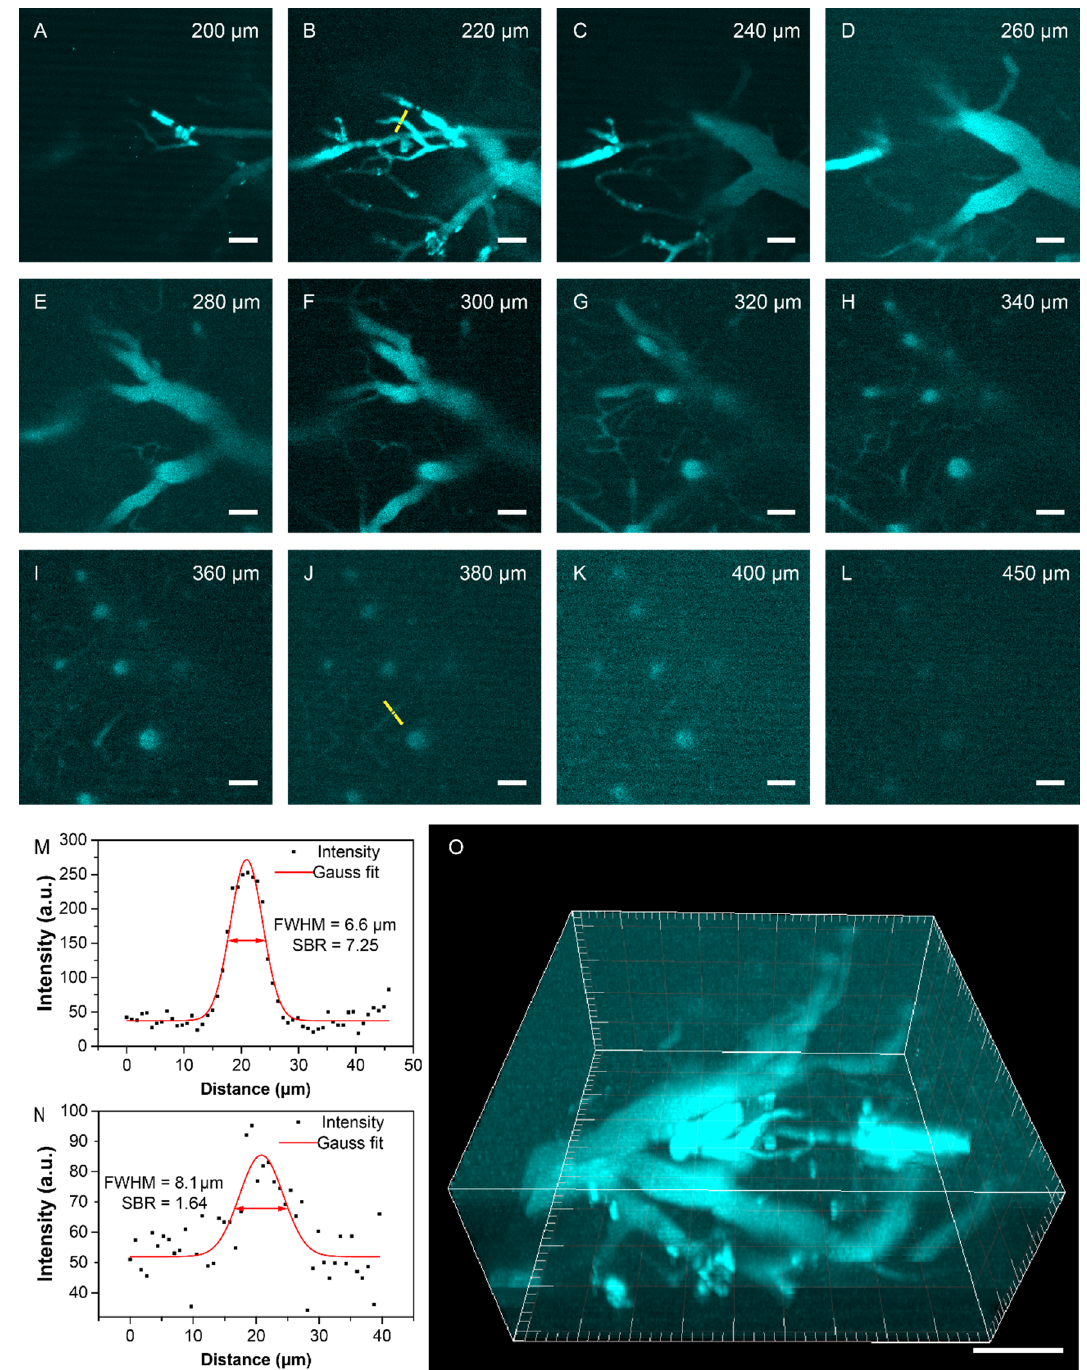
Figure 4. In vivo anti-Stokes fluorescence confocal microscopic imaging. ( A–L ) In vivo anti-Stokes fluorescence confocal microscopic images of brain blood vessels at various depths following the injection of BPN-BBTD dots (2 mg/mL, 200 µ L) under 980 nm continuous-wave laser excitation. Scale bar: 50 μ m. ( M ) and ( N ) are the intensity distributions along the yellow lines in ( B ) and ( J ), respectively. The Gauss fits are shown in red curves. ( O ) The 3D reconstruction of a mouse’s cerebral vascular network with 450 μ m depth. Scale bar: 100 μ m.